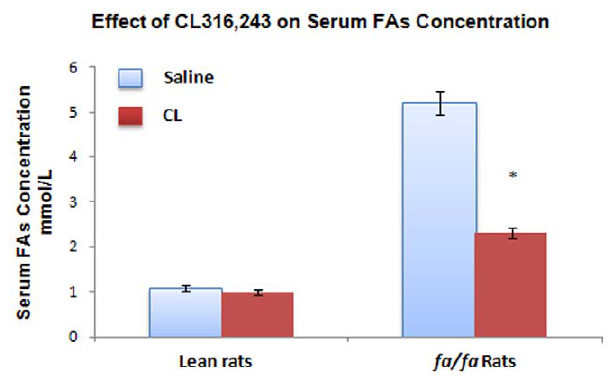
Figure 5. Effect of CL 316,243 on serum FAs concentration. * P , 0.05 , compares the significant differences between the two groups of lean and fa/fa rats.